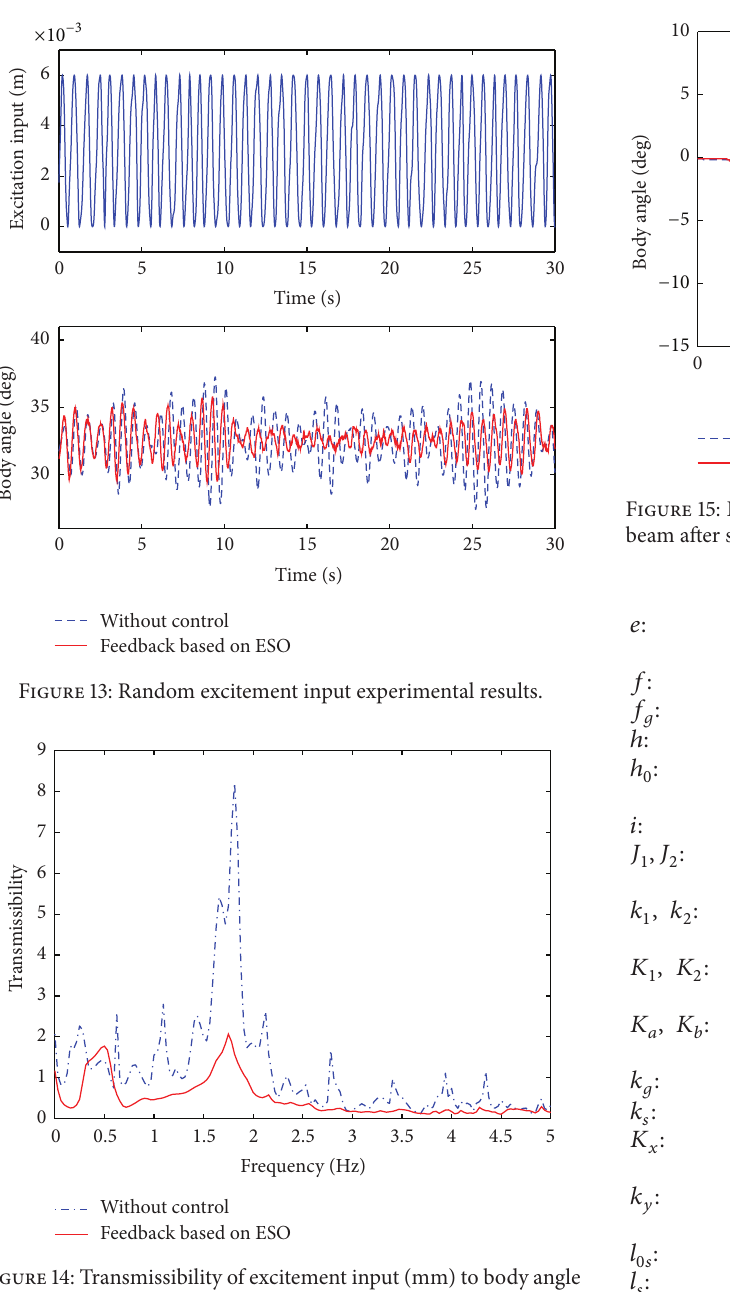
Figure 14: Transmissibility of excitement input (mm) to body angle output (degree) of experiment.